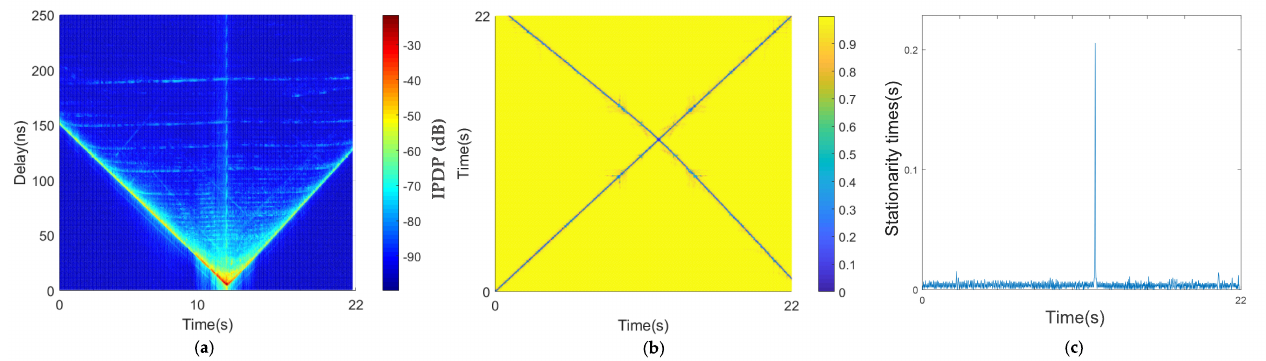
Figure 14. Results of the opposite traveling beam bridge scenario: ( a ) average PDPs, ( b ) temporal PDP correlation coefficient, and ( c ) stationarity time